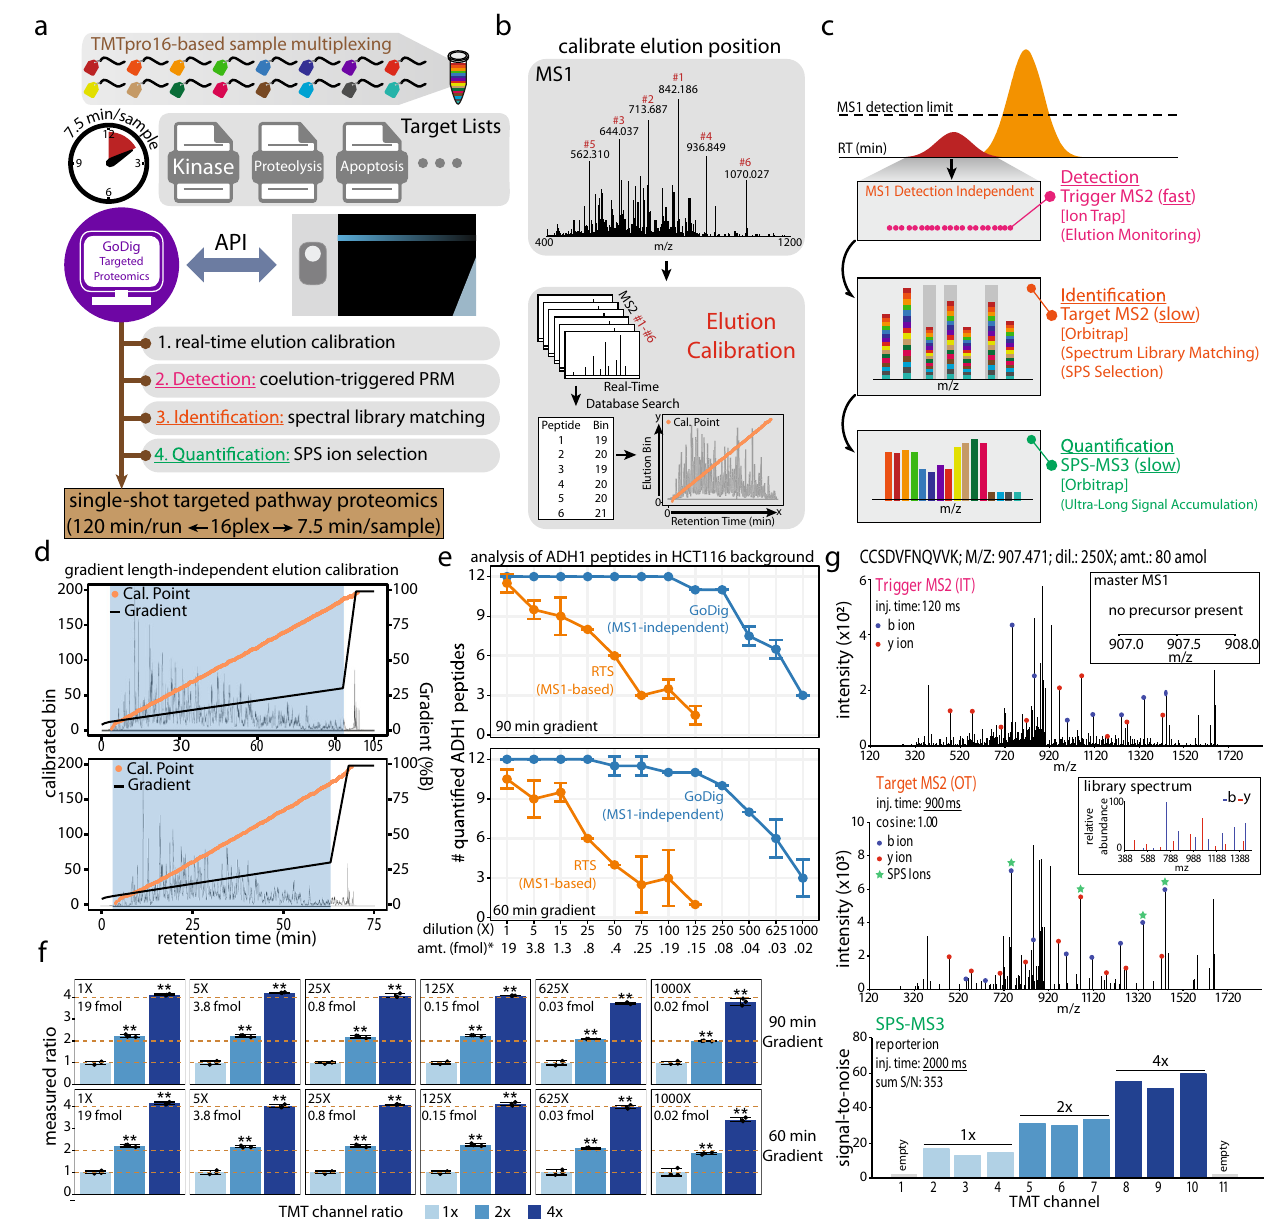
Fig. 1 | GoDig enables real-time pro fi ling for targeted proteomics. GoDig uses real-time analytics to locate each target analyte relative to prominent background ions present in each sample a – d . The resulting quantitation is more sensitive than competing MS1-based approaches ( e ) and results in high-quality identi fi cation ( g ) and quanti fi cation ( f ) of each analyte. a GoDig governs several functionalities prompting a variety of scans to perform multiplexed targeted proteomics: (1) elutioncalibrationinreal-timeusing abundantMS1peaks;(2)detection:coelution- triggered parallel reaction monitoring (PRM) scans for elution monitoring; (3) identi fi cation: high-resolution spectrum library matching; (4) quanti fi cation: syn- chronous precursor selection (SPS) and ultra-long injection MS3 collection. b Episodic elution position prediction. Periodically, a handful of MS2 spectra are taken to precisely determine position. c Once the elution window is calibrated, GoDig triggersfast PRM scansfor lists of peptidetargetsinthewindow to monitor peptide elution without MS1 detection. If a target is detected, a high-resolution MS2scaniscollectedforspectrumlibrarymatchingandSPSionselection,followed by MS3-based quanti fi cation. d Real-time elution calibration using ordered elution